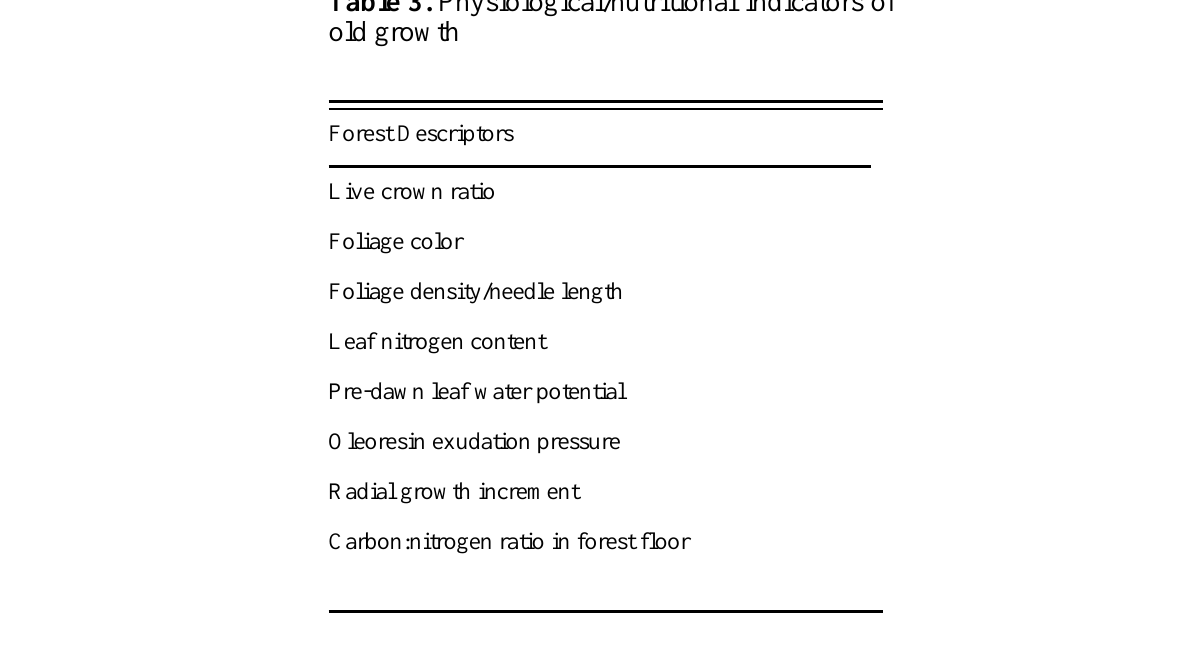
Table 3. Physiological/nutritional indicators